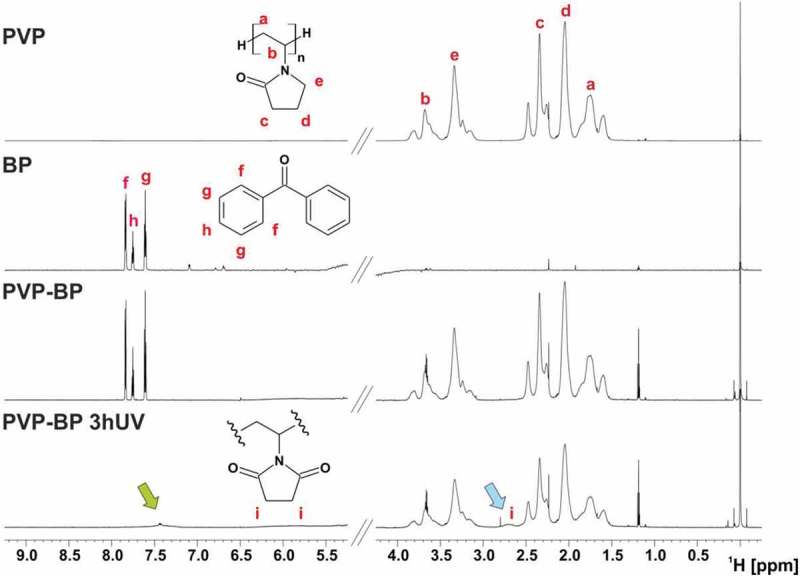
1H NMR spectra of PVP, BP and PVP-BP, before and after 3 h of UV exposure (800 MHz, 60% H2O/40% D2O, 25°C). Green arrow (~7.5 ppm) indicates up-shifted and broadened signal of BP after 3 h irradiation. Blue arrow denotes additional broad signal around 2.6 ppm assigned to the methylene protons of the succinimide ring.